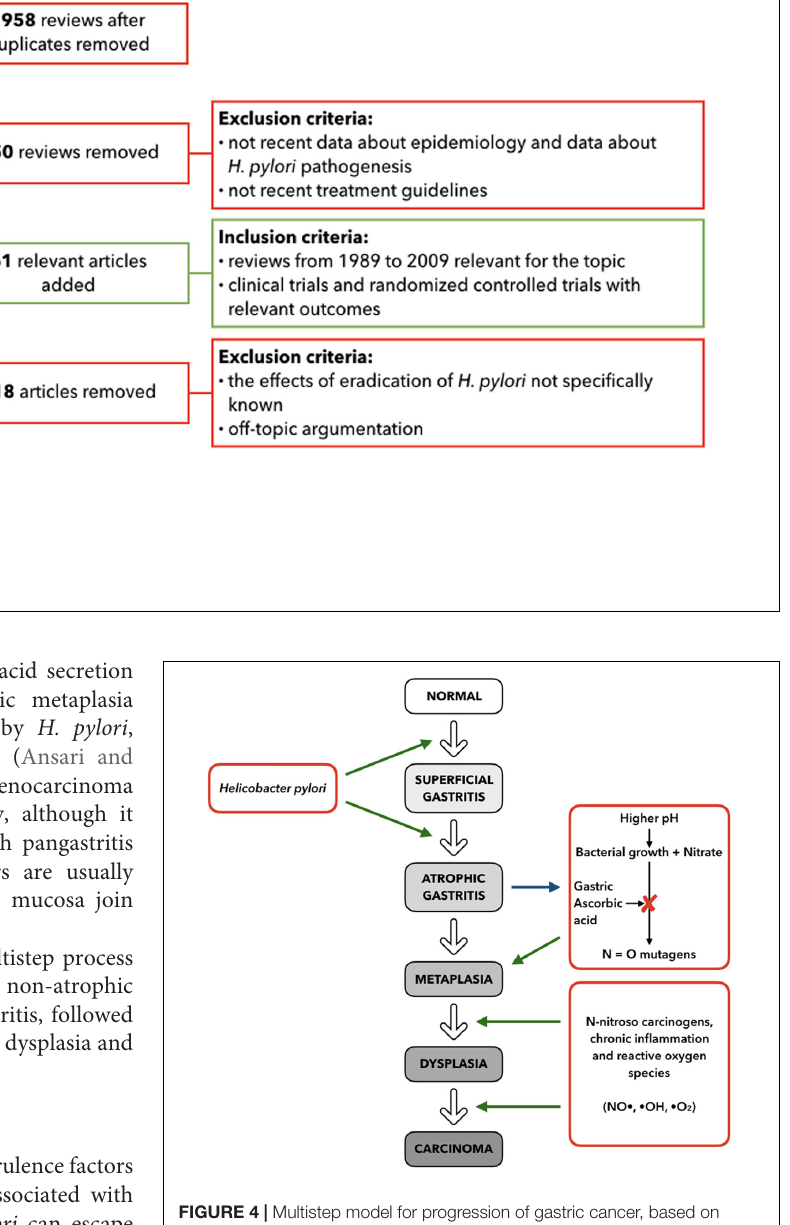
of both the H. pylori virulence factors ( Figure 5 ) and the mechanisms of disease